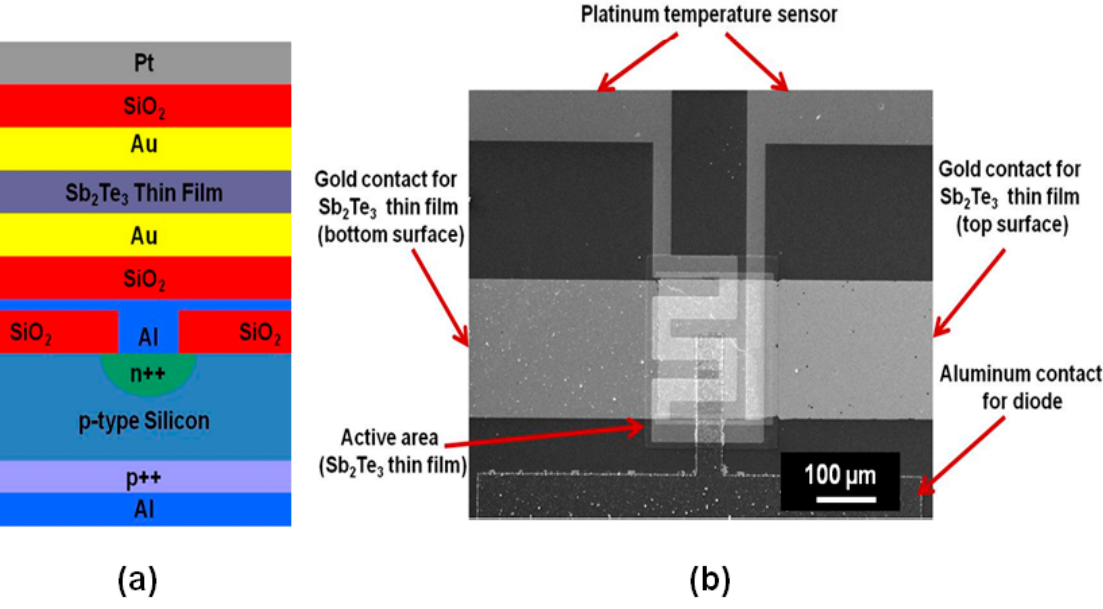
Figure 1. ( a ) Schematic of the cross-section of a cross-plane TE device for measurement of the cross-plane Seebeck coefficient of Sb 2 Te 3 thin film; ( b ) SEM image of the fabricated TE device.